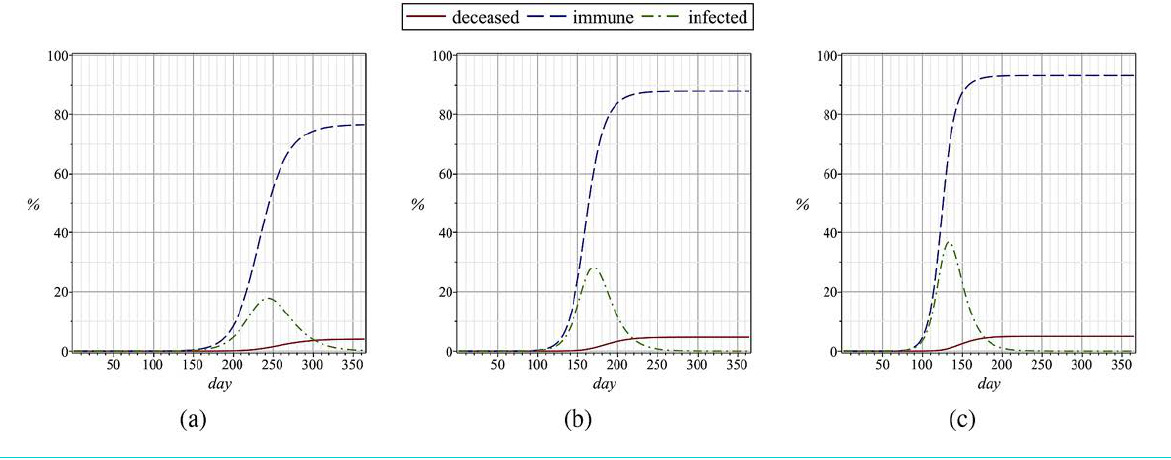
(a), (b) and (c). Dashed lines represent the im- ) and solid lines the deceased ( ) population. The values are ℛ 0 = 1.9 ℛ 0 = 2.4 ℛ 0 = 2.9 𝑖𝑖𝑢𝑢𝑢𝑢𝑢𝑢𝑢𝑢𝑢𝑢 𝑖𝑖𝑢𝑢𝑢𝑢𝑢𝑢 𝑢𝑢𝑢𝑢𝑡𝑡𝑢𝑢 𝑛𝑛 + 𝑛𝑛 𝑛𝑛